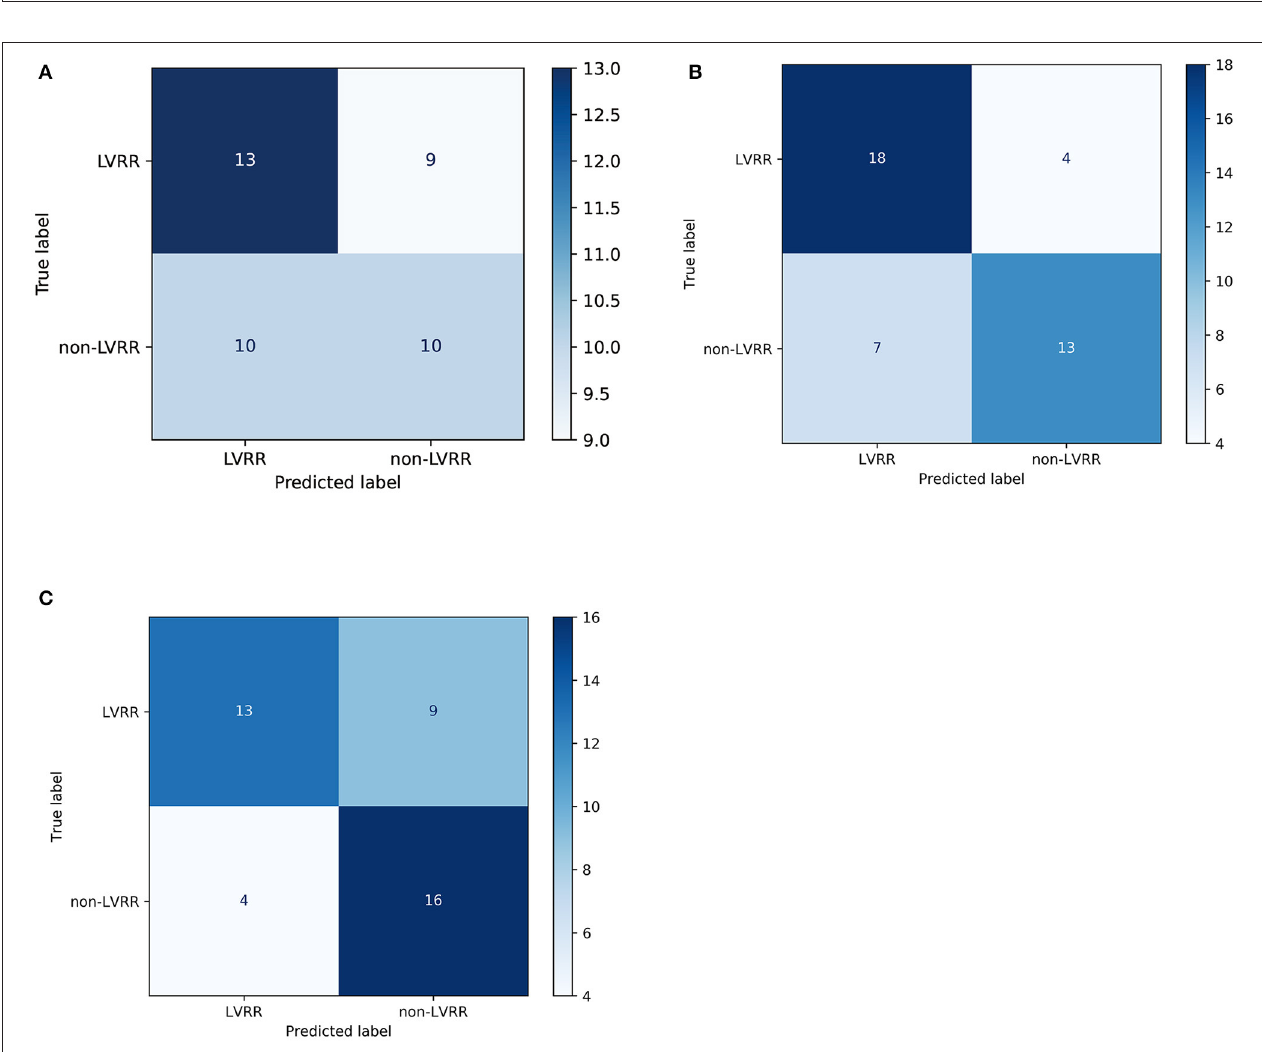
FIGURE 4 | Confusion matrices of the predictive models. The confusion matrix of the logistic regression model (A) , random forest (B) , and XGBoost (C) in the testing set ( ∼ 40% of the cohort). Predicted label: the sum of each column represents the predicted sample number of the classes. True label: the sum of each row represents the true sample number of the